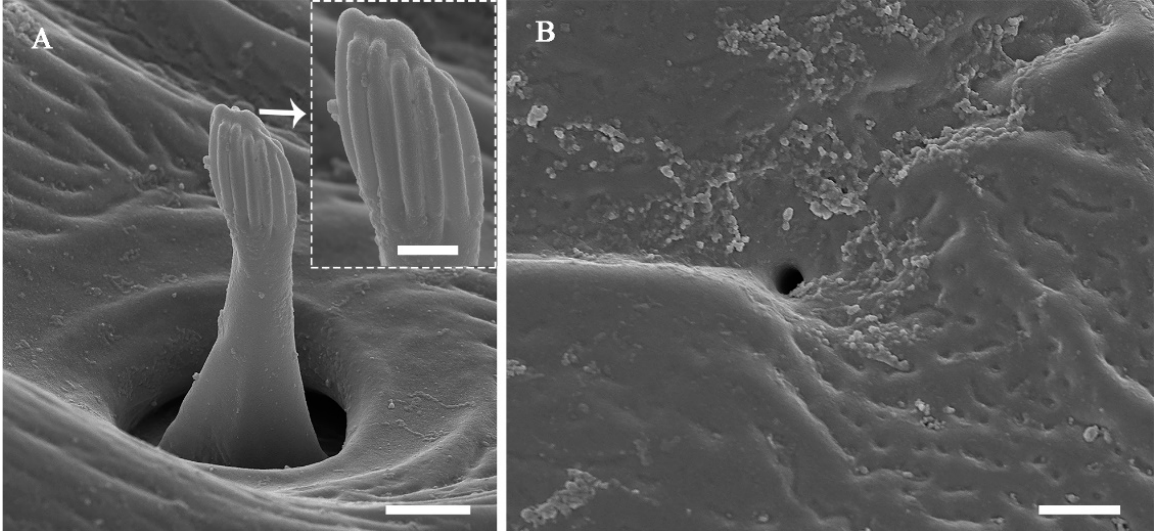
Figure 12. Fine morphology of sensilla coeloconica and cuticular pores on the antennae of C. qinlingensis . ( A ) Characteristic peg with finger-like projections located in a flexible cuticular socket on flagellomere 35. The inset shows that no surface pores are present on fingerlike projections. ( B ) Cuticular pore on the antennal cuticle. Scale bar: A and B = 1 μ m; inset = 500 nm.